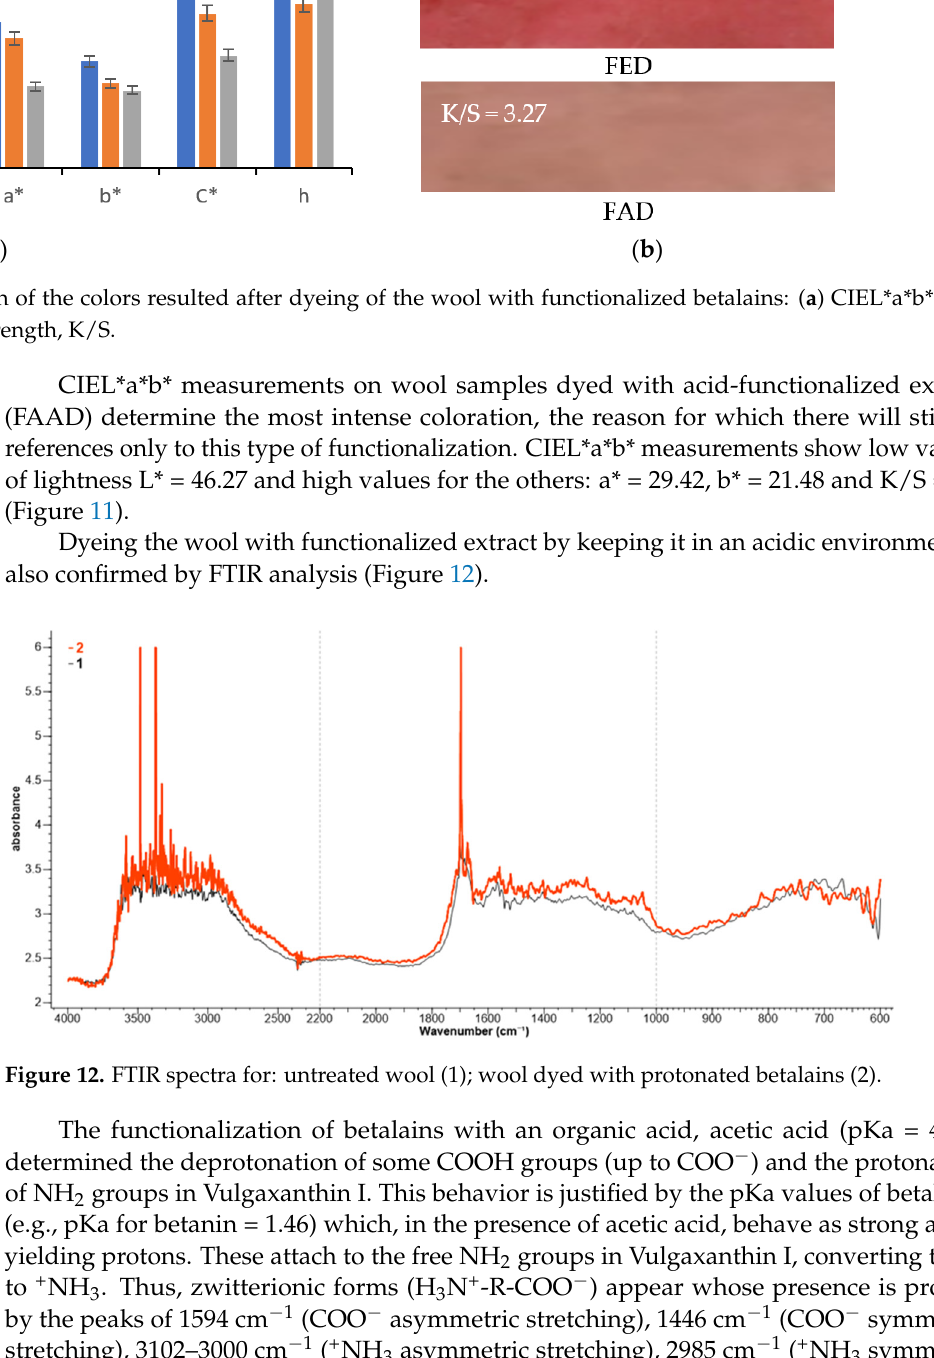
Figure 12. FTIR spectra for: untreated wool (1); wool dyed with protonated betalains